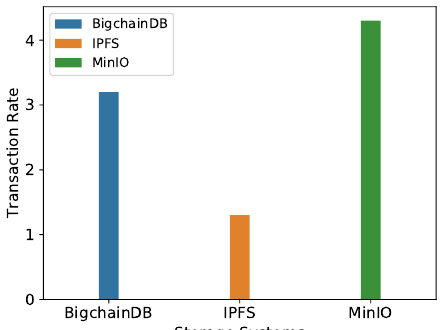
Figure 4. Transaction rate achieved by each storage